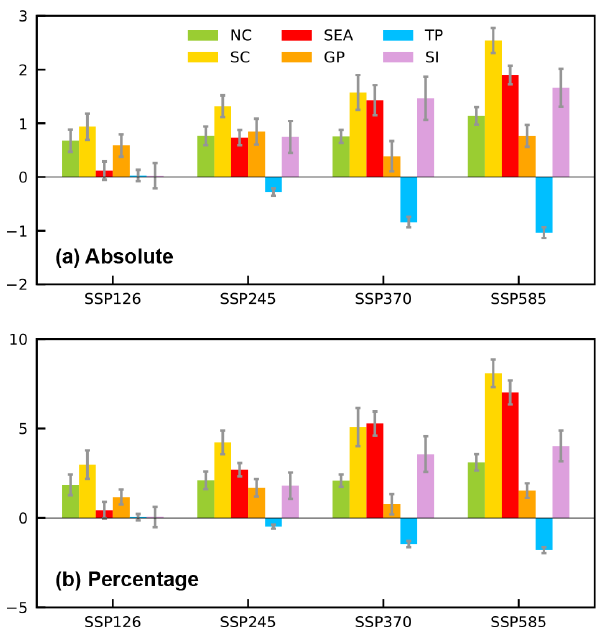
Figure 8. Absolute ( a , ppb) and percentage ( b , %) changes in projected near-surface climate-driven O 3 concentrations in 2095 (2091–2100 mean) relative to 2025 (2020–2029 mean) over the six selected key regions of Asia, including NC, SC, SEA, SI, GP, and TP under four future climate scenarios. The error bars indicate 1 standard